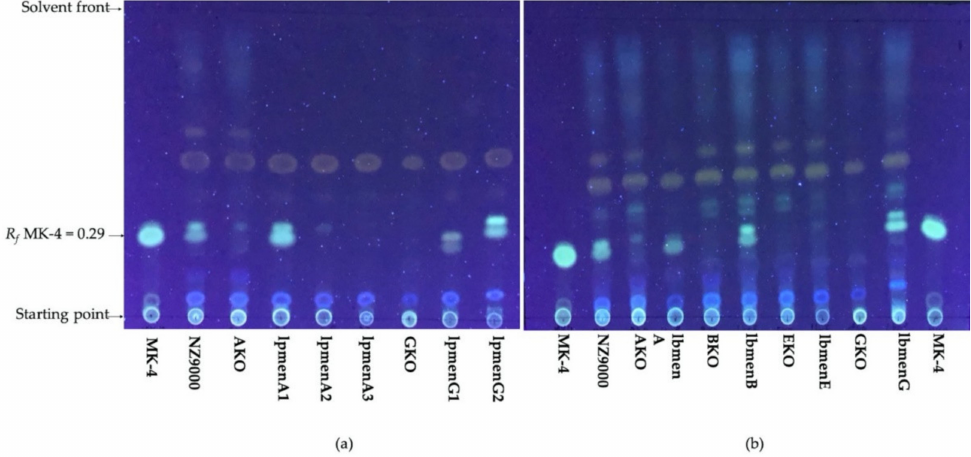
Figure 2. Menaquinone detection on TLC of the menaquinone extracts from L. lactis NZ9000; its deficient strains ∆ menA (AKO), ∆ menB (BKO), ∆ menE (EKO), and ∆ menG (GKO); and the engineered strains with complementing biosynthesis genes from ( a ) Lactipl . plantarum WCFS1 ( lpmenA1 , lpmenA2 , lpmenA3 , lpmenG1 , lpmenG2 ) and ( b ) Lent . buchneri DSM 20057 ( lbmenA , lbmenB , lbmenE , lbmenG ). Menaquinone with four isoprenoid residues was used as standard